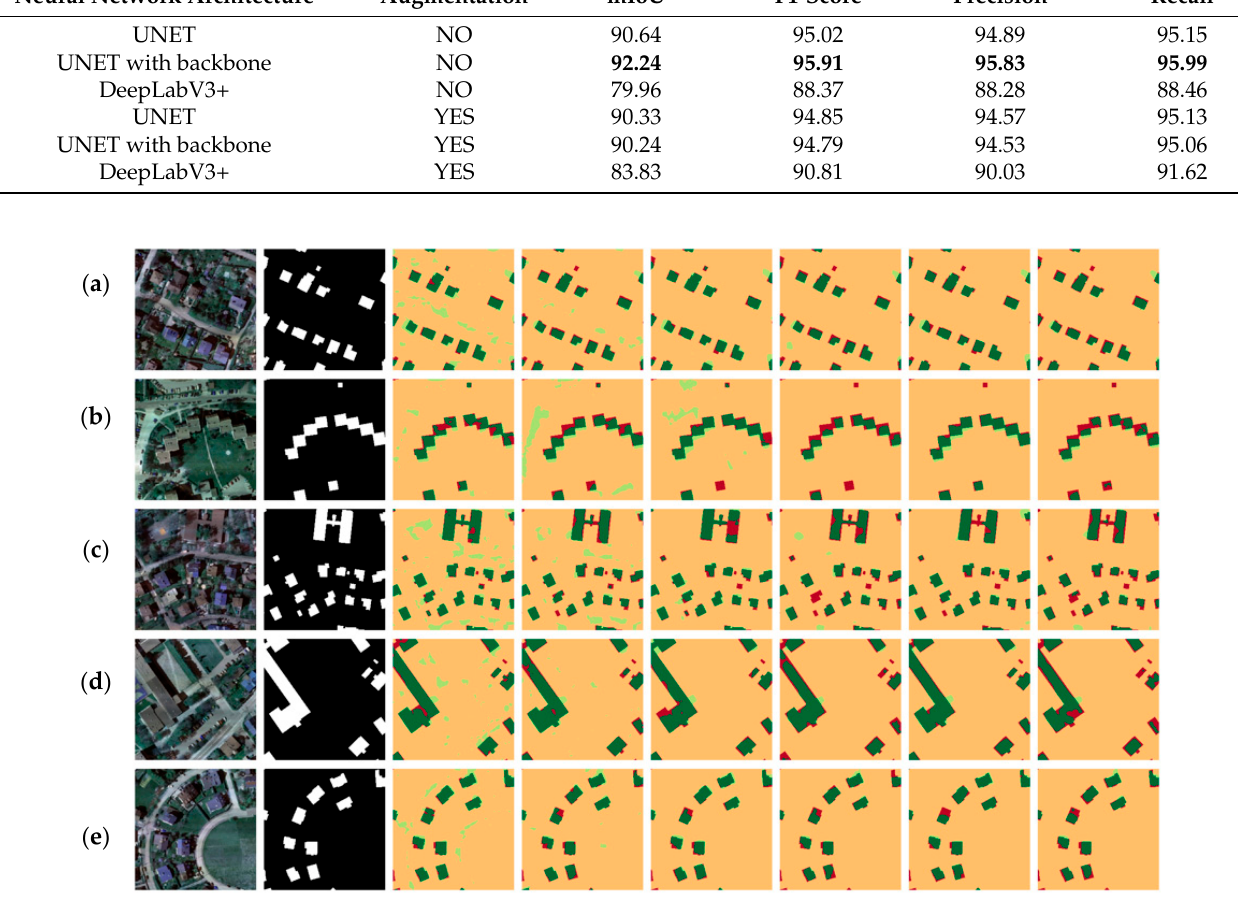
Figure 7. Visualisation of the results for the 0.5 m dataset. From left: input image, ground truth, DeepLab, DeepLab with augmentation, UNET, UNET with augmentation, UNET_bb, UNET_bb with augmentation. Colours: dark green—TP, orange—TN, light green—FP, red—FN. ( a – e ) various examples from the test